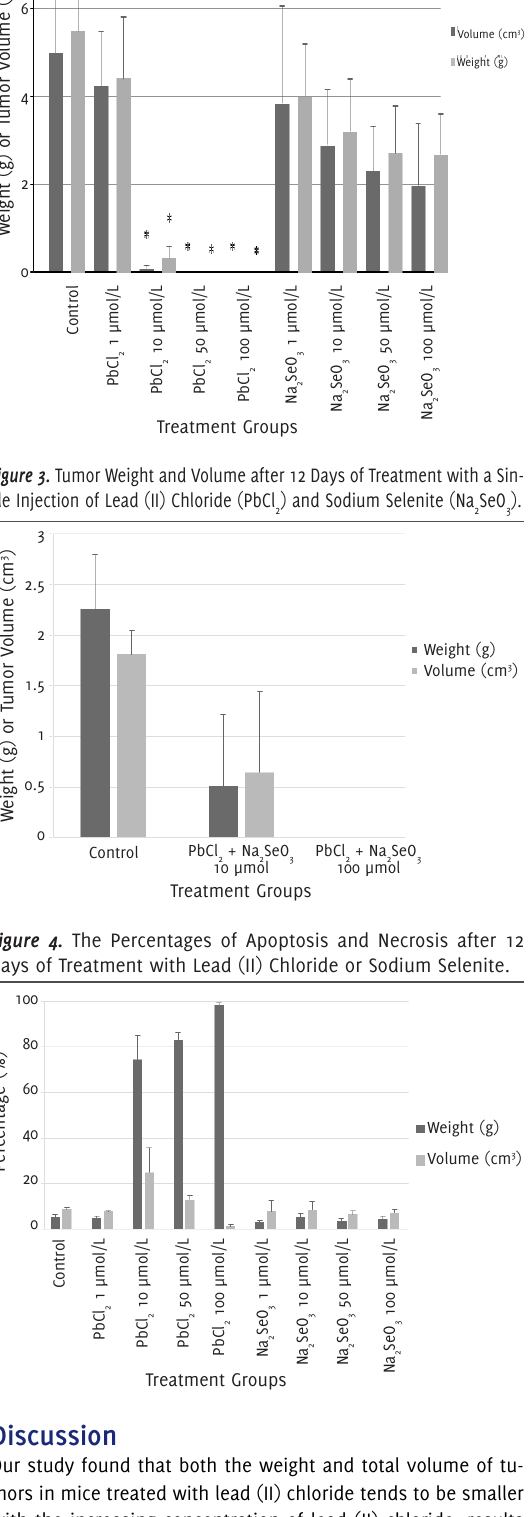
Figure 2. Tumor Weight and Volume after 12 days of Treat- ment with Lead (II) Chloride or Sodium Selenite.